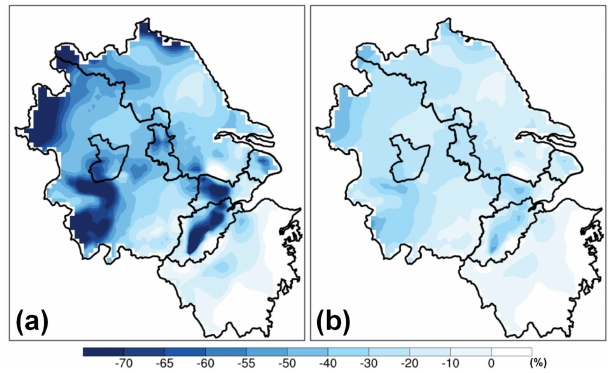
Figure 9. (a) Spatial distributions of the PM 2 . 5 mitigation poten- tial across the YRD and (b) their differences with the impacts of long-term emission control strategies from 2016 to 2019 (Fig. 5f). Both spatial patterns of long-term emission control strategy impacts (Fig. 5f) and the localized PM 2 . 5 mitigation potential in the main urban areas of Hangzhou (Fig. S10), with the proportion calculator, result in panel (a)